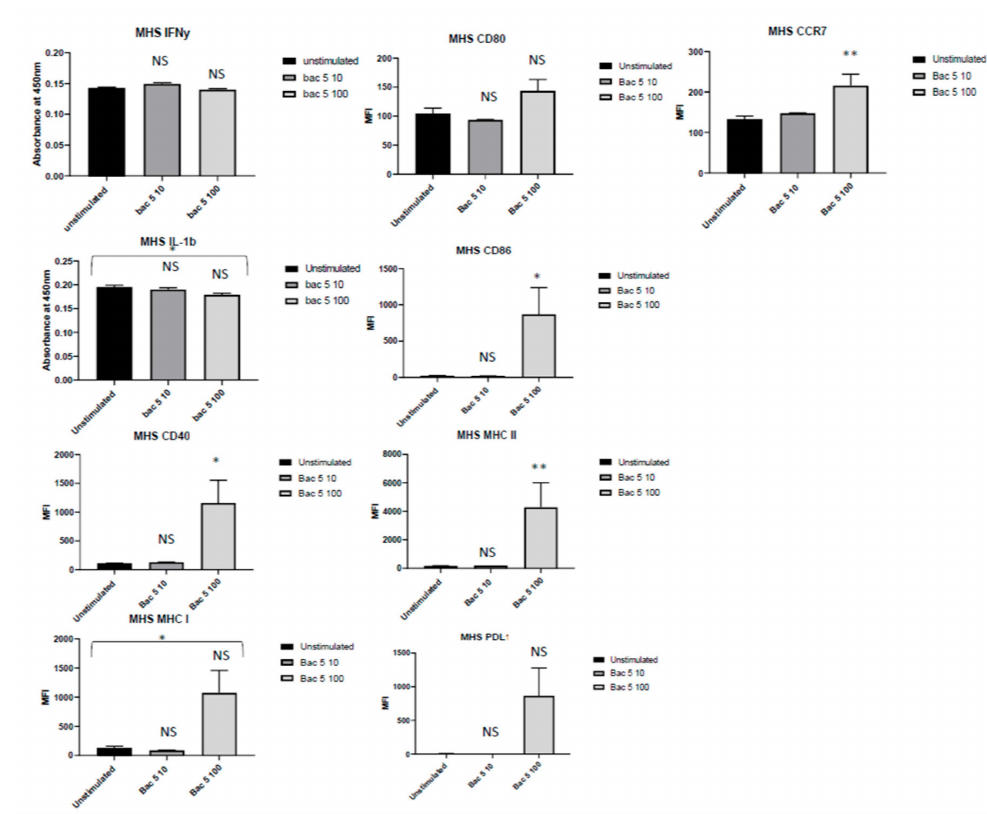
Figure 2. Upregulation of cell surface markers on MH-S Cells by Bac5. 1 × 10 6 cells were incubated with either 10 or 100 ug / mL Bac5 peptide at 37 ◦ C for 72 h. In all conditions, cells were initially stained with eFluor780 viability dye before subsequent immunostaining with fluorescently labelled antimurine target-specific IgG antibody as described. Mean fluorescent intensity (MFI) of at least 30,000 events was assessed by flow cytometry on viable cells using a Beckton Dickinson machine with FlowJo v.10.6.2. The data displayed is a representative figure from three independent repeats. One-way ANOVA with Kurskal-Wallis test for multiple comparisons was performed for each condition (** = p < 0.01, * = p < 0.1, NS = No Significance).